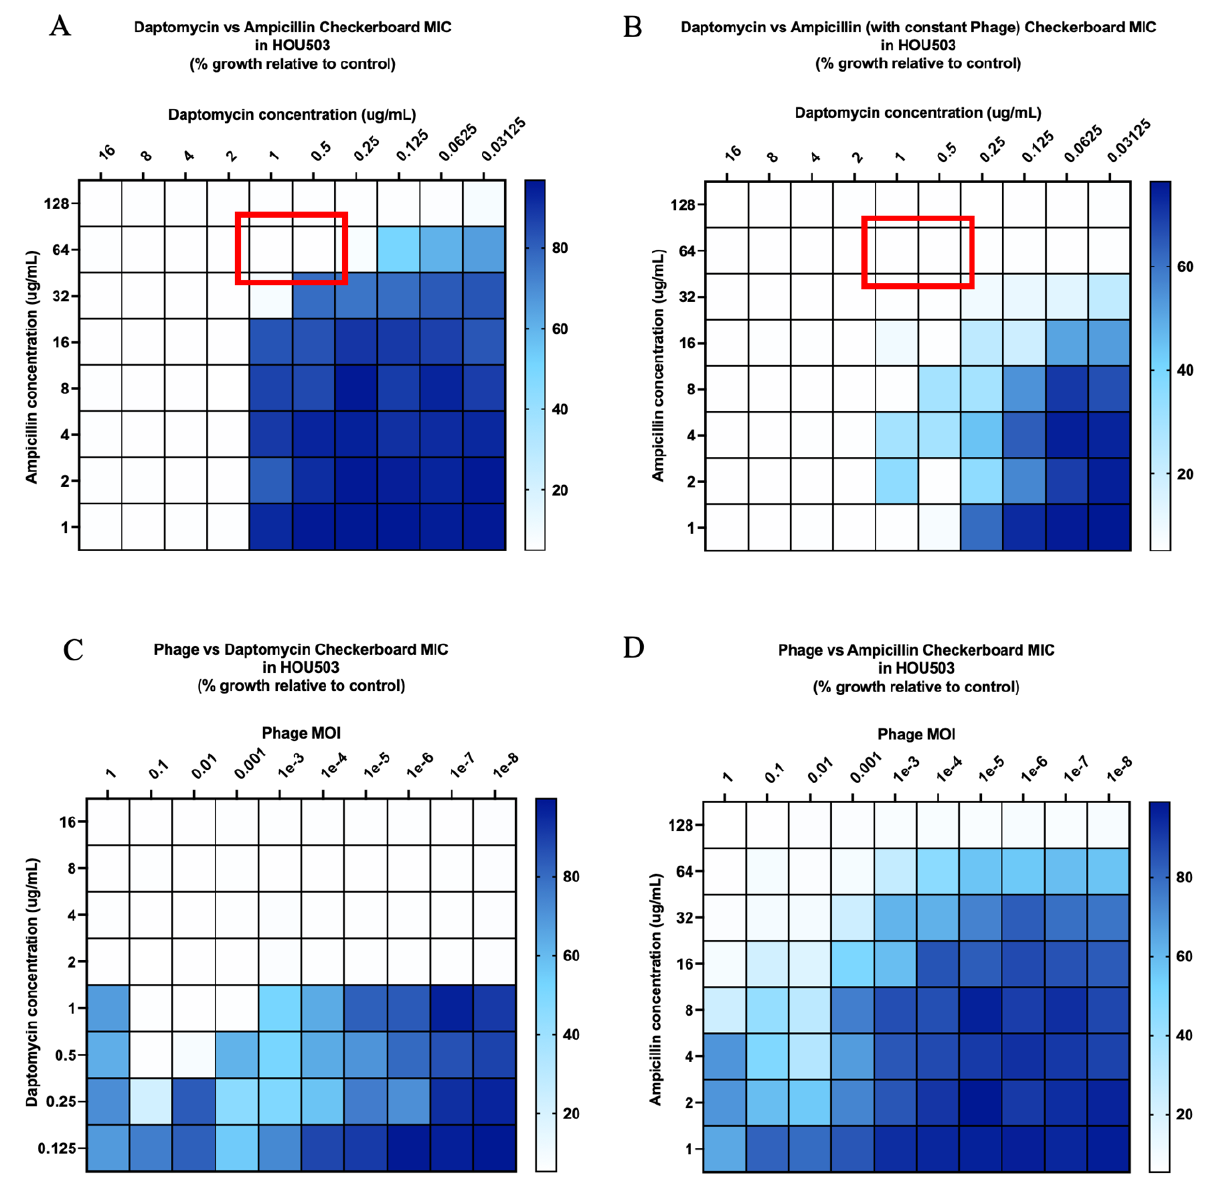
Figure 2. ( A – D ) Checkerboard analysis of E. faecium strain HOU503. Additivity, defined as an FIC index > 0.5 but <4, is indicated by the red outline in Figure 1A,B. Comparisons are versus growth control and depicted by the blue color gradient as percentage of growth.